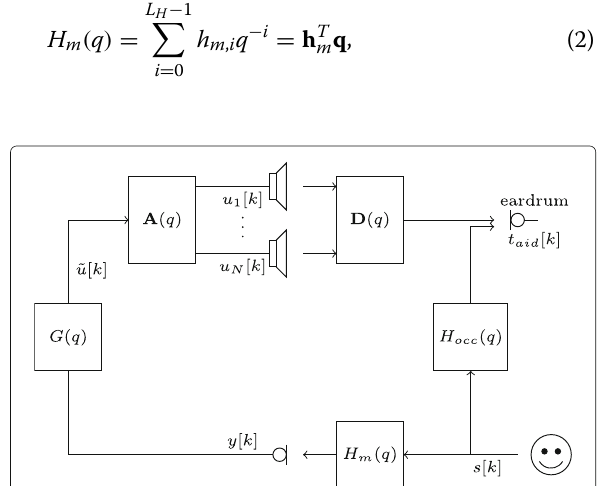
Fig. 2 Generic single-microphone multi-loudspeaker hearing device setup considered in this